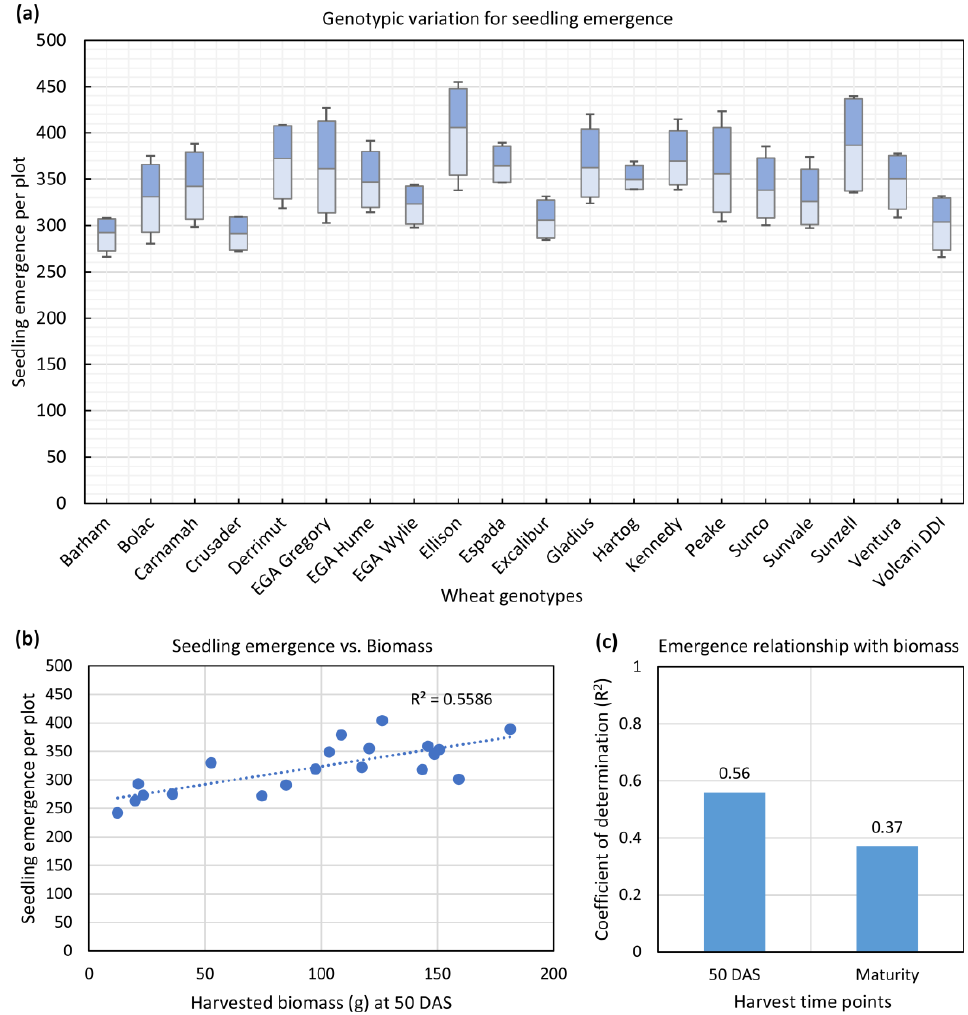
Figure 6. Seedling emergence profile of wheat genotypes and its effects on biomass in terms of the coefficient of determination (R 2 ). (a) Variation of emergence between different genotypes of wheat as estimated from the method. Each of the floating column summarizes the variability among four replications; maxima and minima are represented by the top and bottom whiskers, respectively, 25th and 75th quartile represented by the second lower and second upper whiskers, respectively, and the average is represented by the middle whisker; (b) R 2 of seedling emergence with the harvested biomass at vegetative growth stage of 50 DAS shown using a linear regression plot; (c) R 2 of seedling emergence on harvested biomass at 50 DAS and maturity.